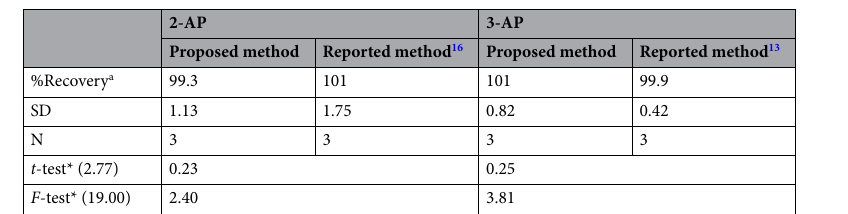
Table 4. Statistical comparison of the results obtained by the proposed method and the reported methods for determination of 2-AP and 3-AP in pure form. *Numbers in parentheses are the tabulated t and F values at p = 0.05. a Each result is the average of 3 different